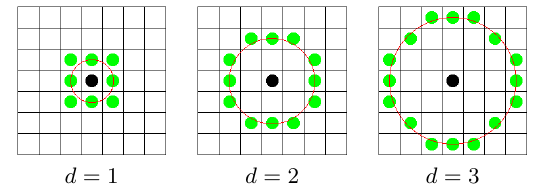
Figure 4: Example of a circular symmetric structure of neighbor- hood. This technique is used here.